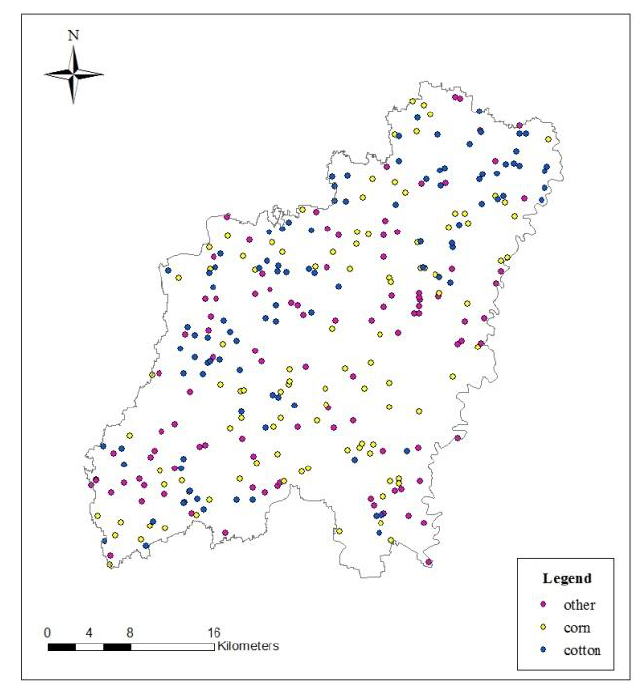
Figure 6.Autumn crop accuracy evaluation checkpoint distribution map in Jingxian